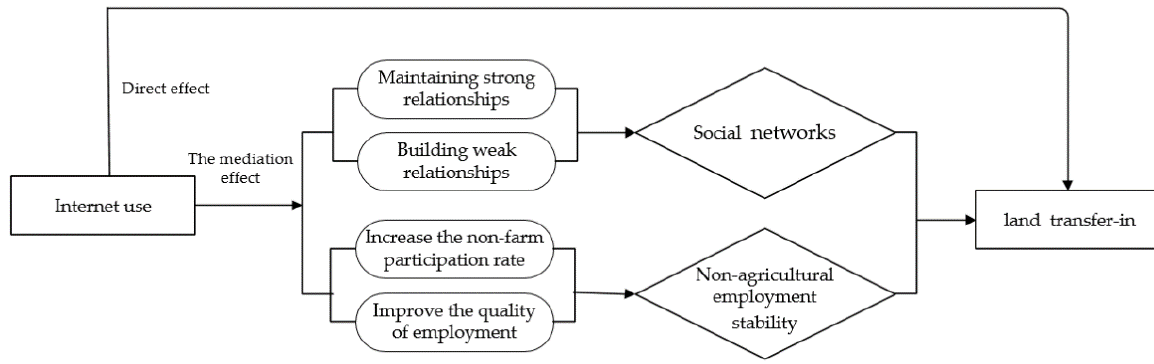
Figure 1. Theoretical analysis framework.